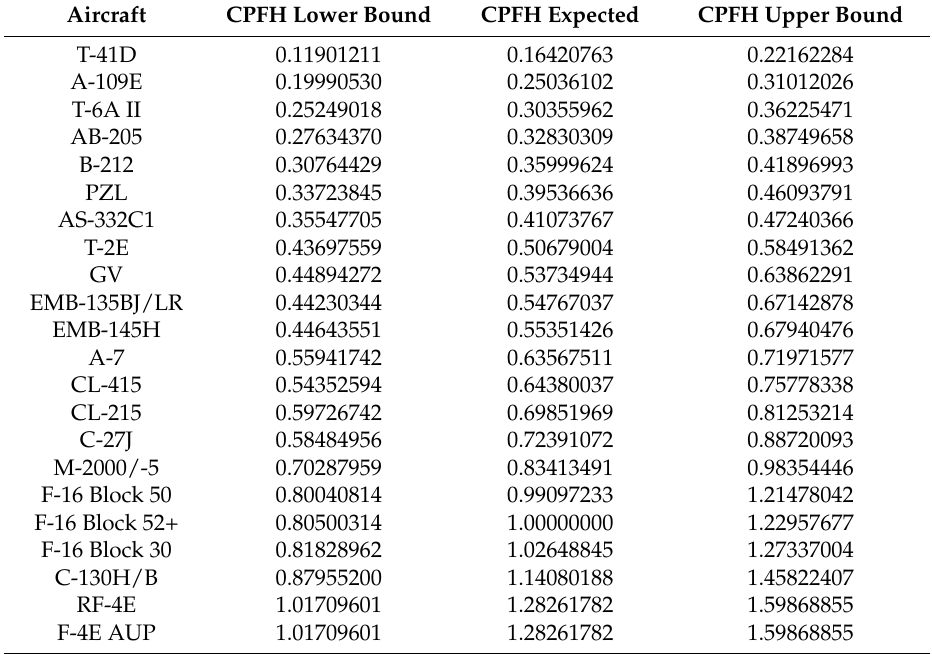
Table 6. Comparison of mean CPFH and 95% CI for the training sample. The figures indicate ‘times the mean CPFH of F-16 Block 52+.’